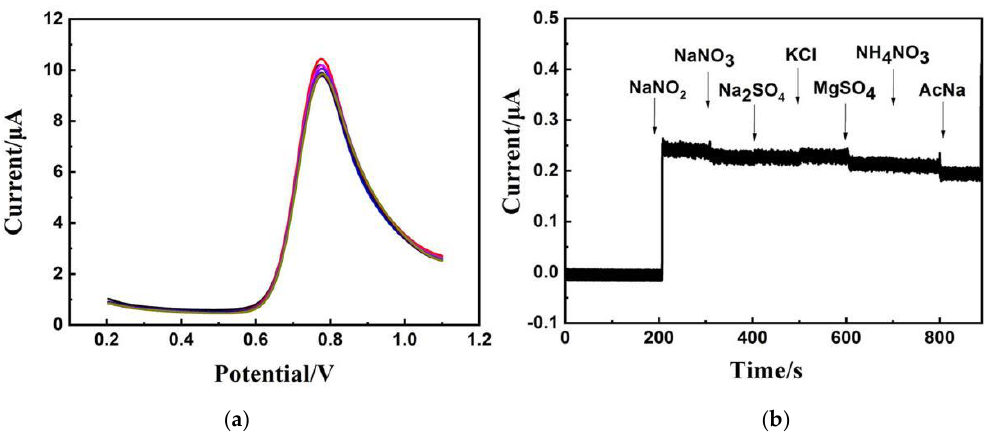
Figure 6. ( a ) Amperometric responses of CoO x /C@GCE in 0.1 M PBS with 1 mM nitrite (pH = 3.5) at 0.8 V with 10 times scanning; ( b ) Amperometric responses of CoO x /C@GCE on 20 µM nitrite and 2 mM interferences of NaNO 3 , Na 2 SO 4 , KCl, MgSO 4 , NH 4 NO 3 , and AcNa.